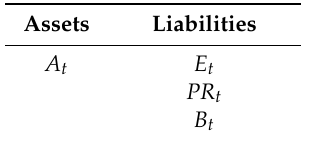
Table 1. Balance sheet of the life insurer at time t